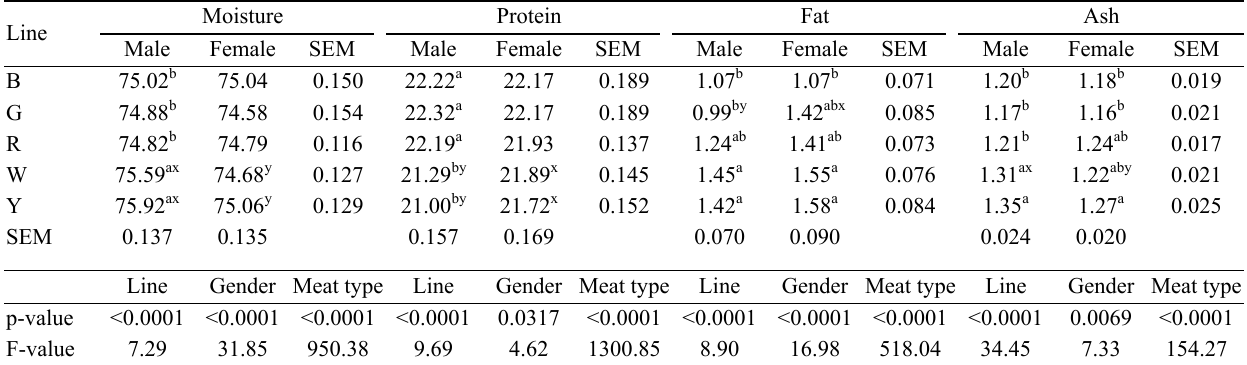
Table 2. Proximate composition (%) of the thigh meat from Korean native chicken breeds Line